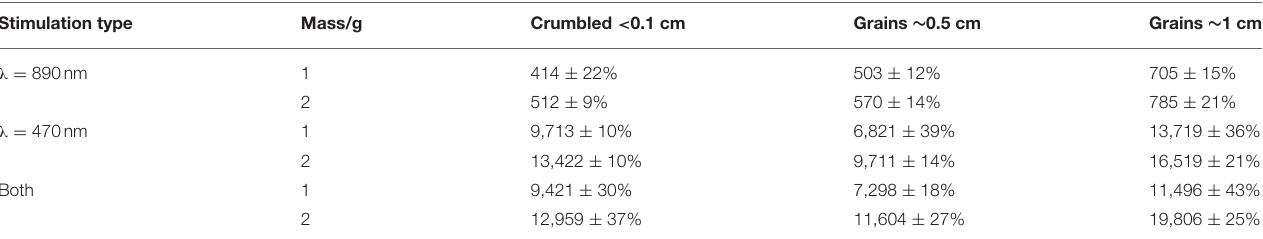
TABLE 2 | Number of counts measured for the samples irradiated with 1Gy for two different masses and three different grain sizes (data acquired with Reader 1). Stimulation type